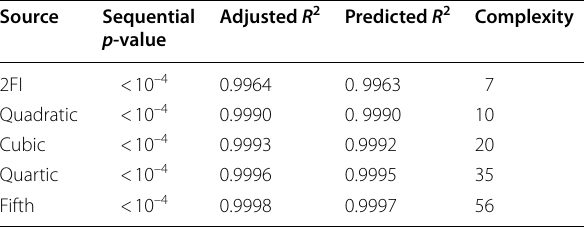
Table 9 SA of different model